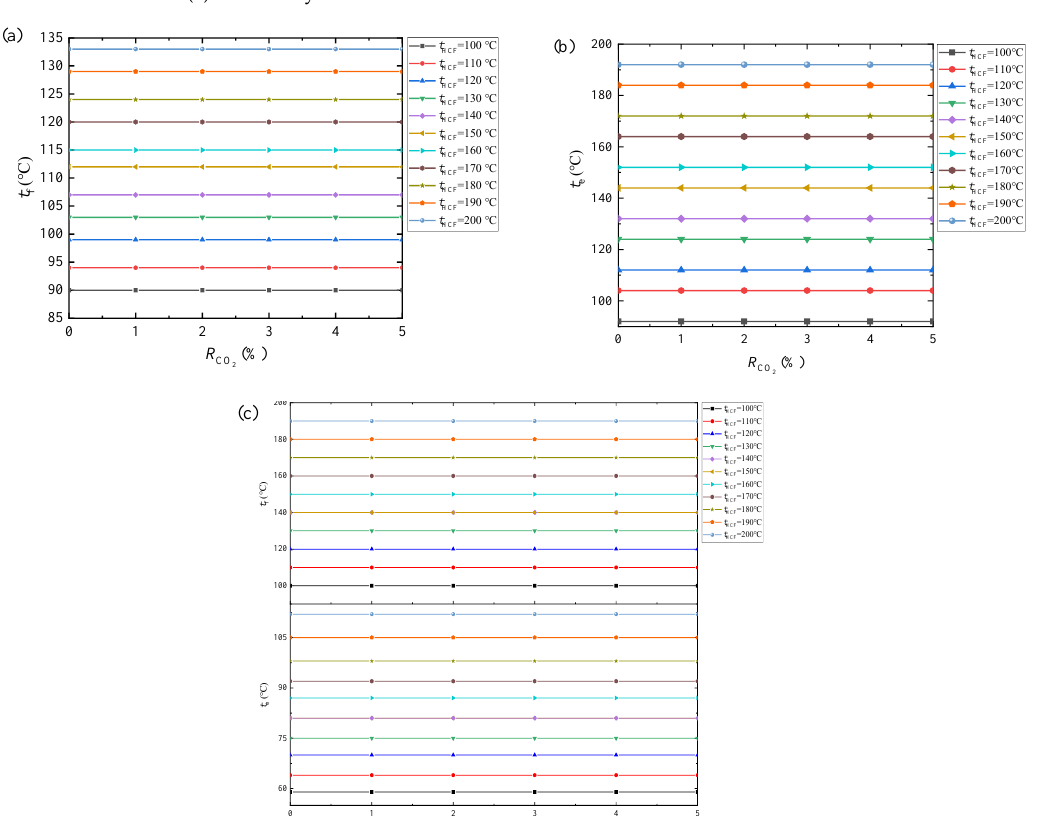
Figure 15. Optimal flash/evaporation temperature corresponding to the optimal W net under different R CO2 and temperatures of heat-carrying fluid: ( a ) SF system, ( b ) ORC system and ( c ) SFORC system.